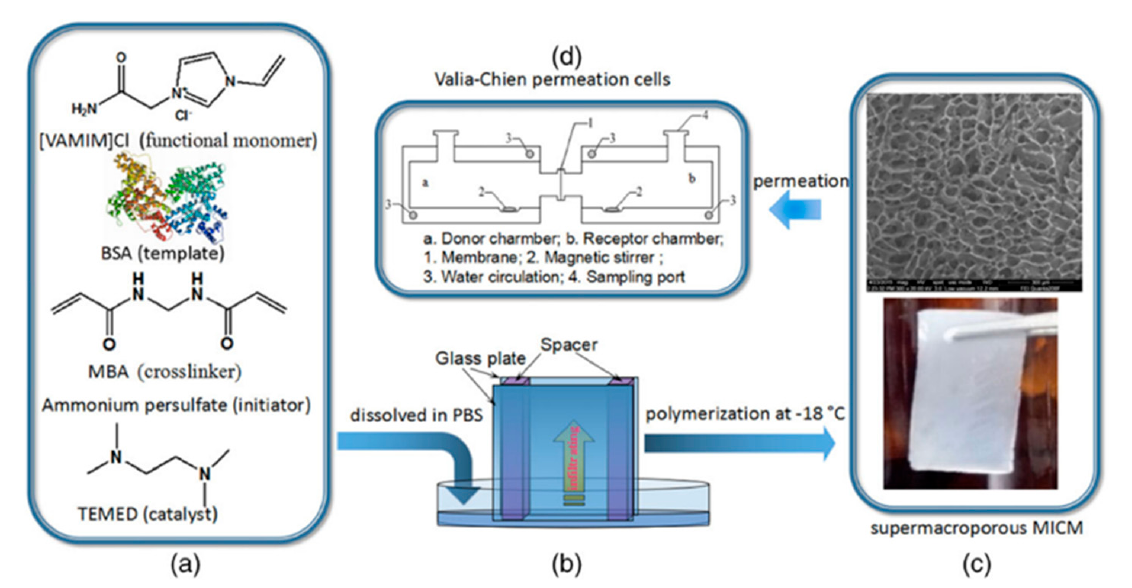
Figure 16. ( a ) Reagents used in the preparation of molecularly imprinted cryogel membrane; ( b ) schematic illustration of the infiltration of pre-polymerization solution between two glass plates; ( c ) the digital photograph (lower) and SEM micrograph (upper) of MIM); ( d ) schematic illustration of Valia–Chien permeation cells. Reprinted with permission from ref [65].